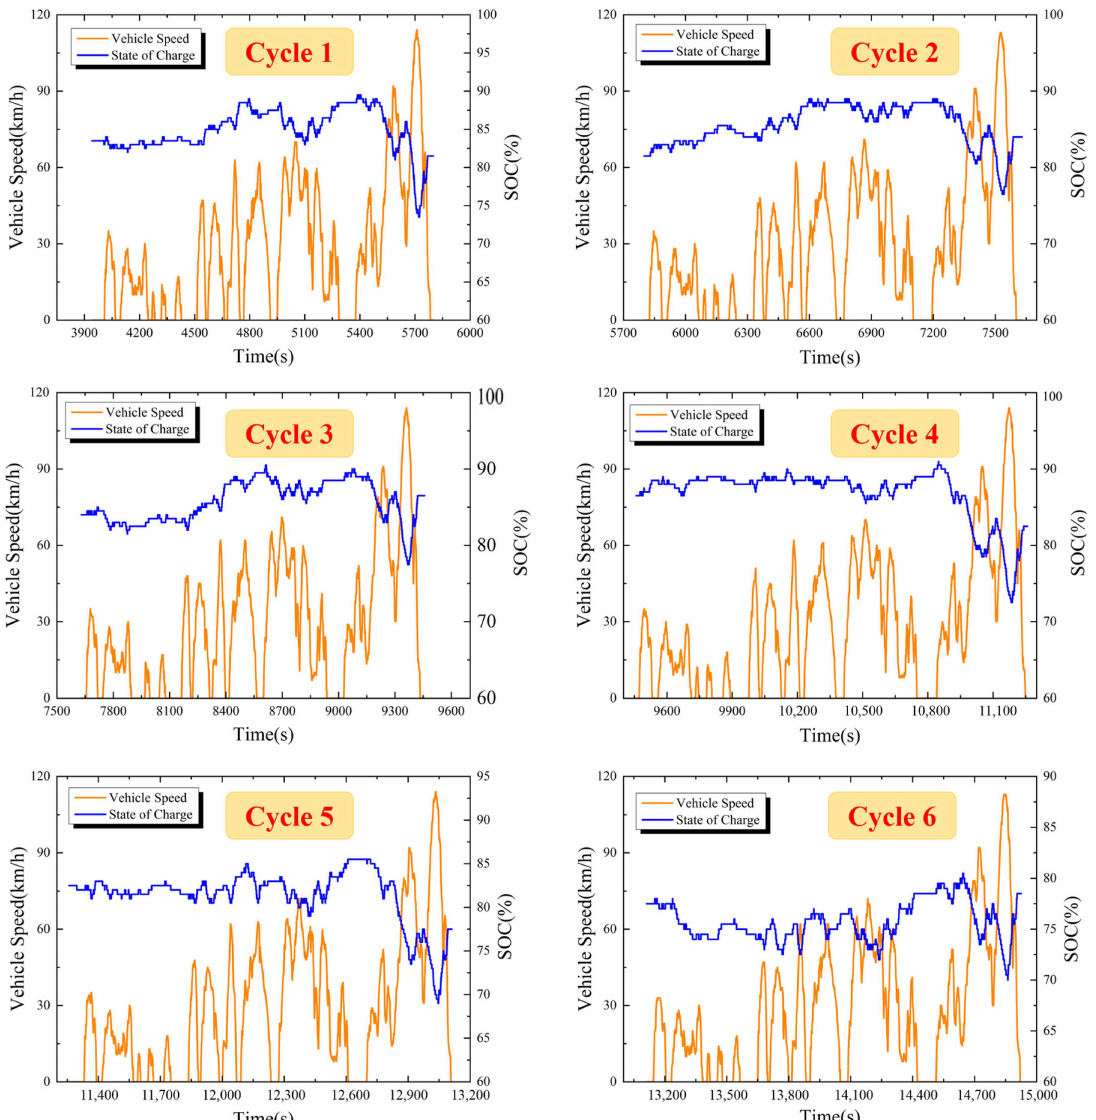
Figure 8. Operating characteristics of vehicle B vehicles under six continuous CLTC-P